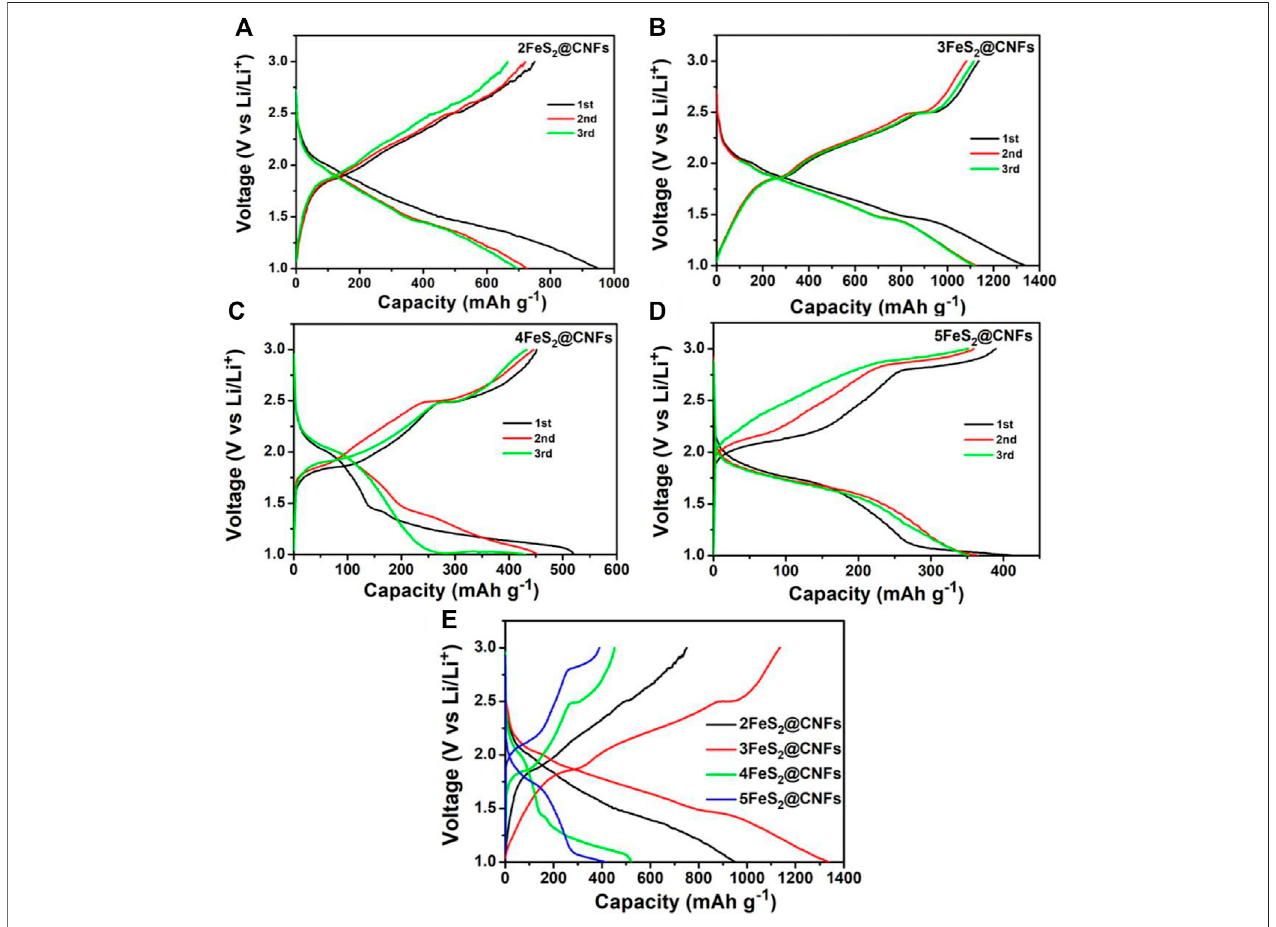
FIGURE 8 | Discharge – charge pro fi les of (A) 2FeS2@CNFs, (B) 3FeS2@CNFs, (C) 4FeS2@CNFs, and (D) 5FeS2@CNFs 20 mA g − 1 between 1 and 3 V; (E) the initial discharge-charge pro fi les of different electrodes at 20 mA g − 1